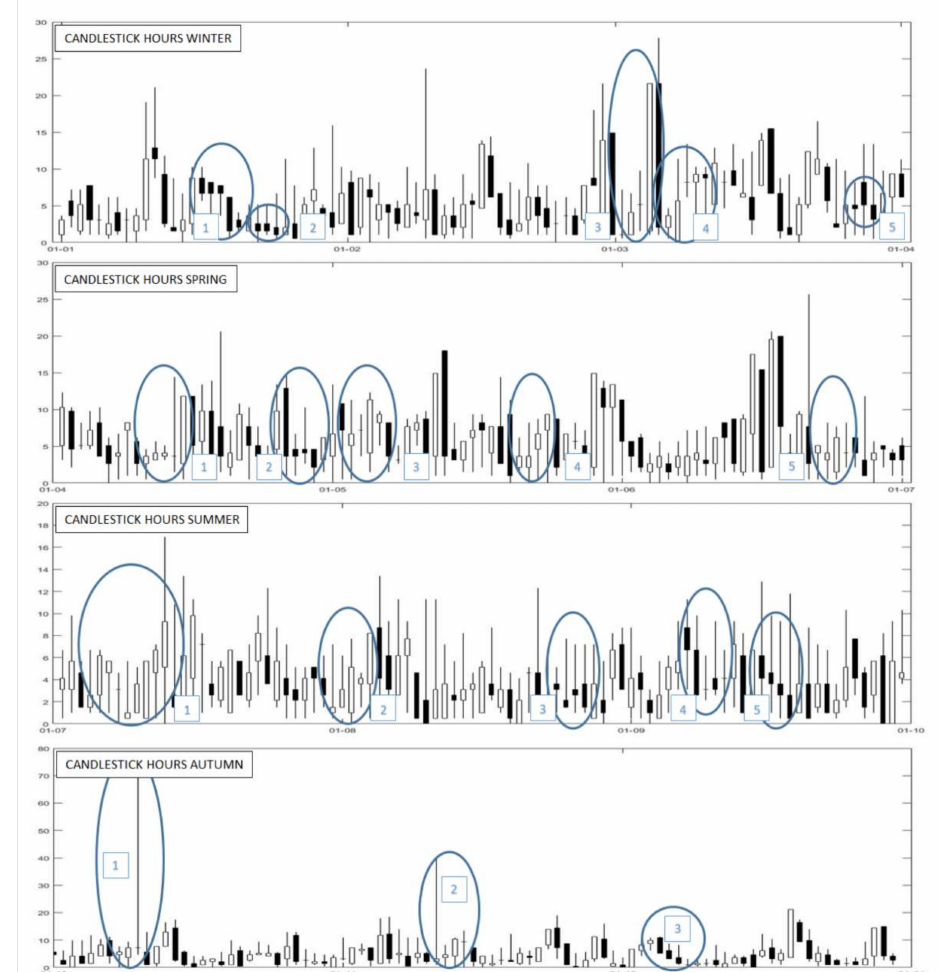
Figure 7. Candlestick chart for Capo Mele data, with daily resolution over a whole